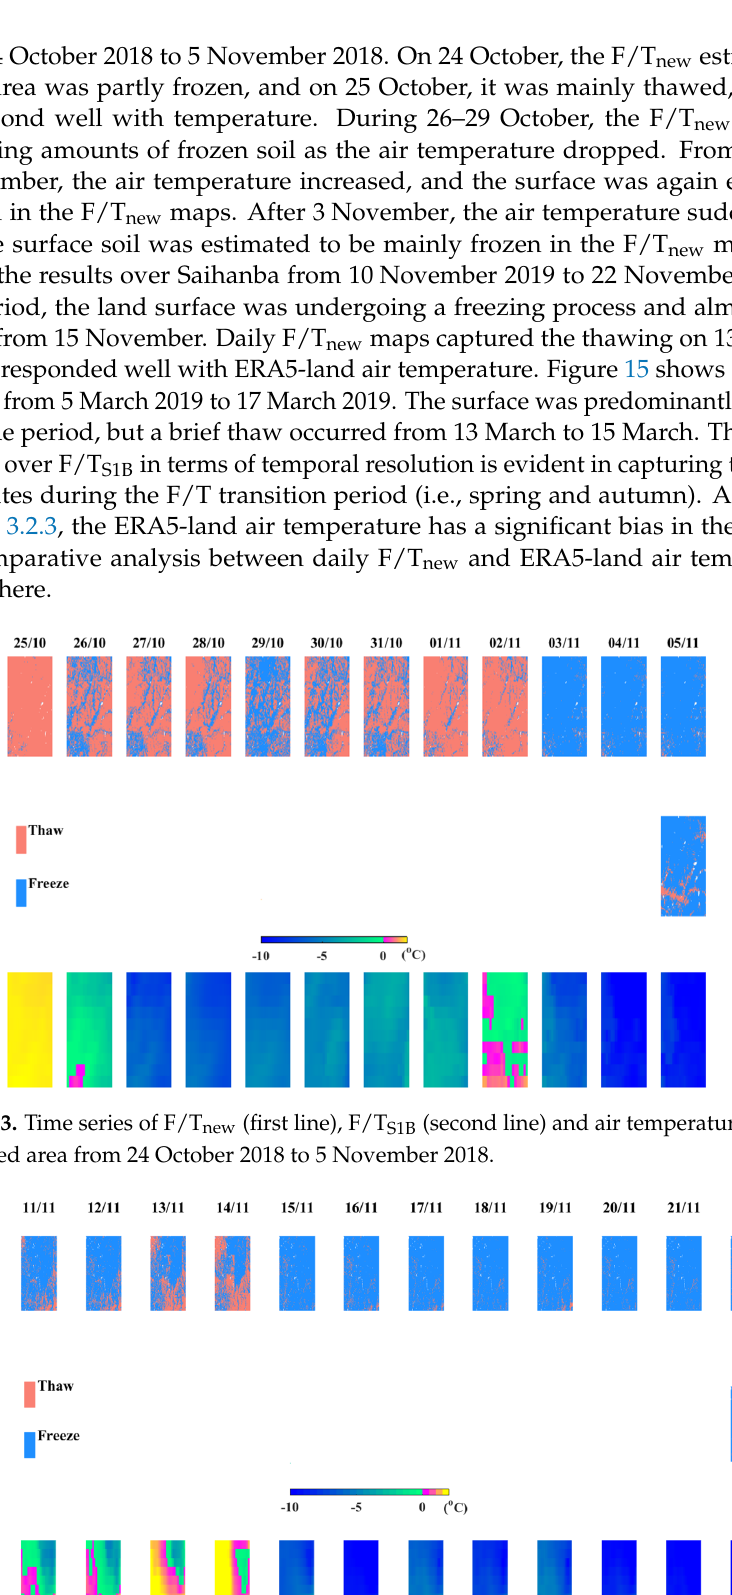
Figure 15. Same as Figure 13 but over the RISMA area from 5 March 2019 to 17 March 2019.